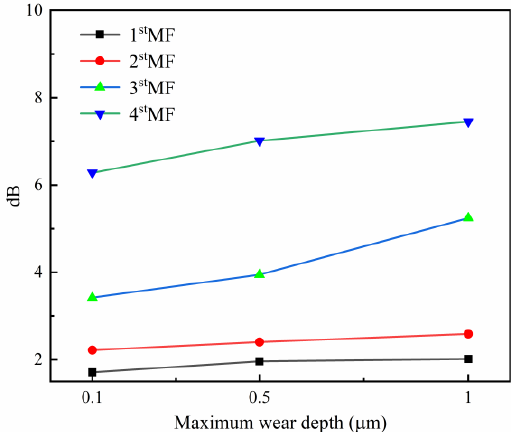
Figure 6. Frequency spectrum of 𝑦̇ 𝑝 with 0.5 μm wear.